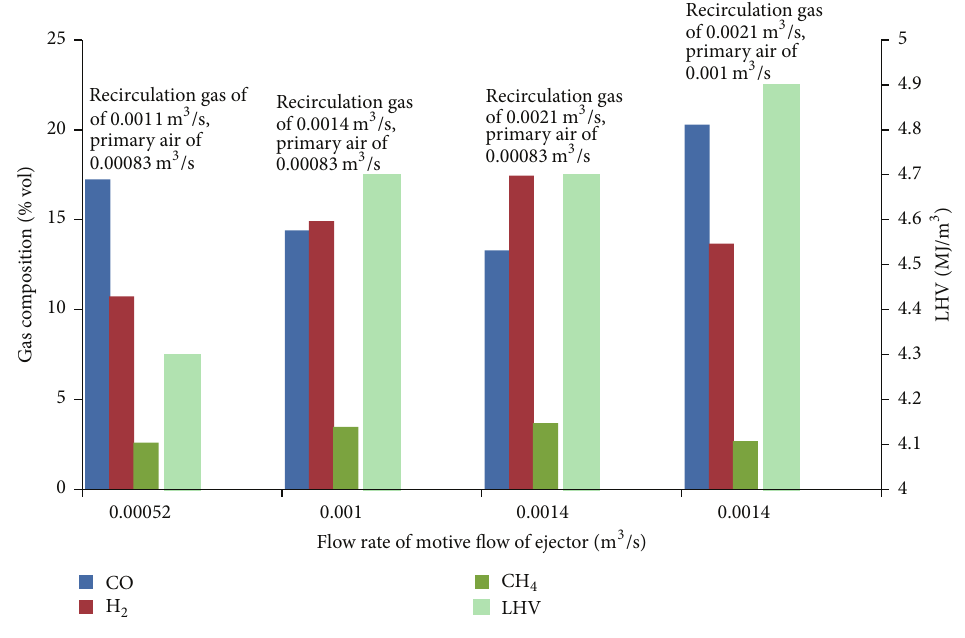
Figure 4: Lower heating values of gases versus motive flow ejector.